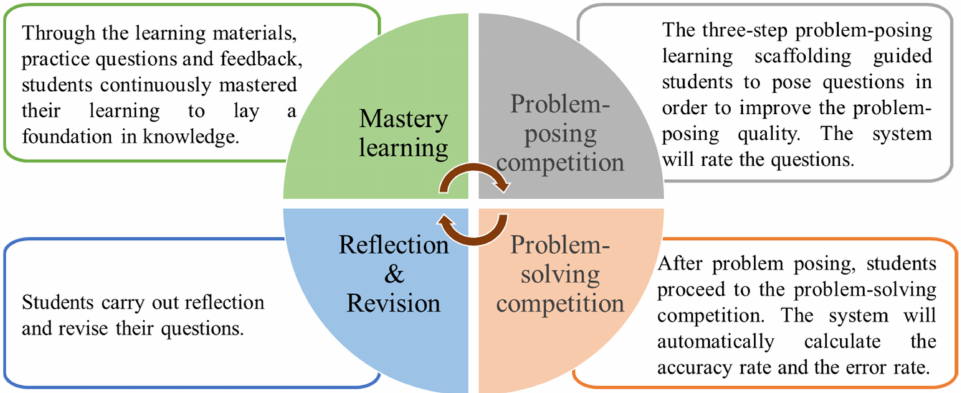
Figure 6. Procedure of the competition-based problem-posing mobile learning